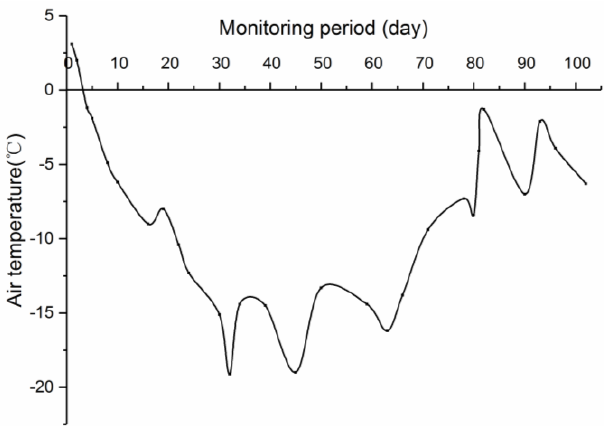
Figure 3. Diagram of air temperature variation during the monitoring period.